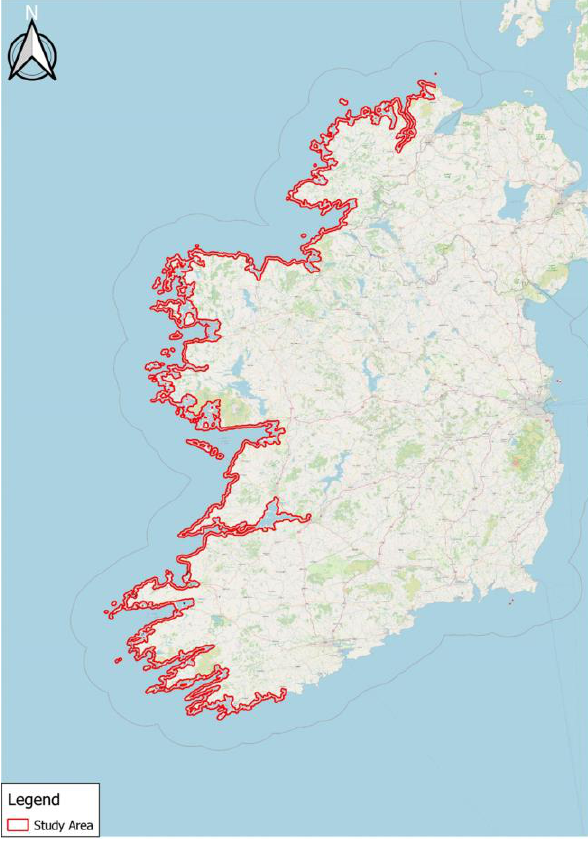
Figure 1 . Figure placement and